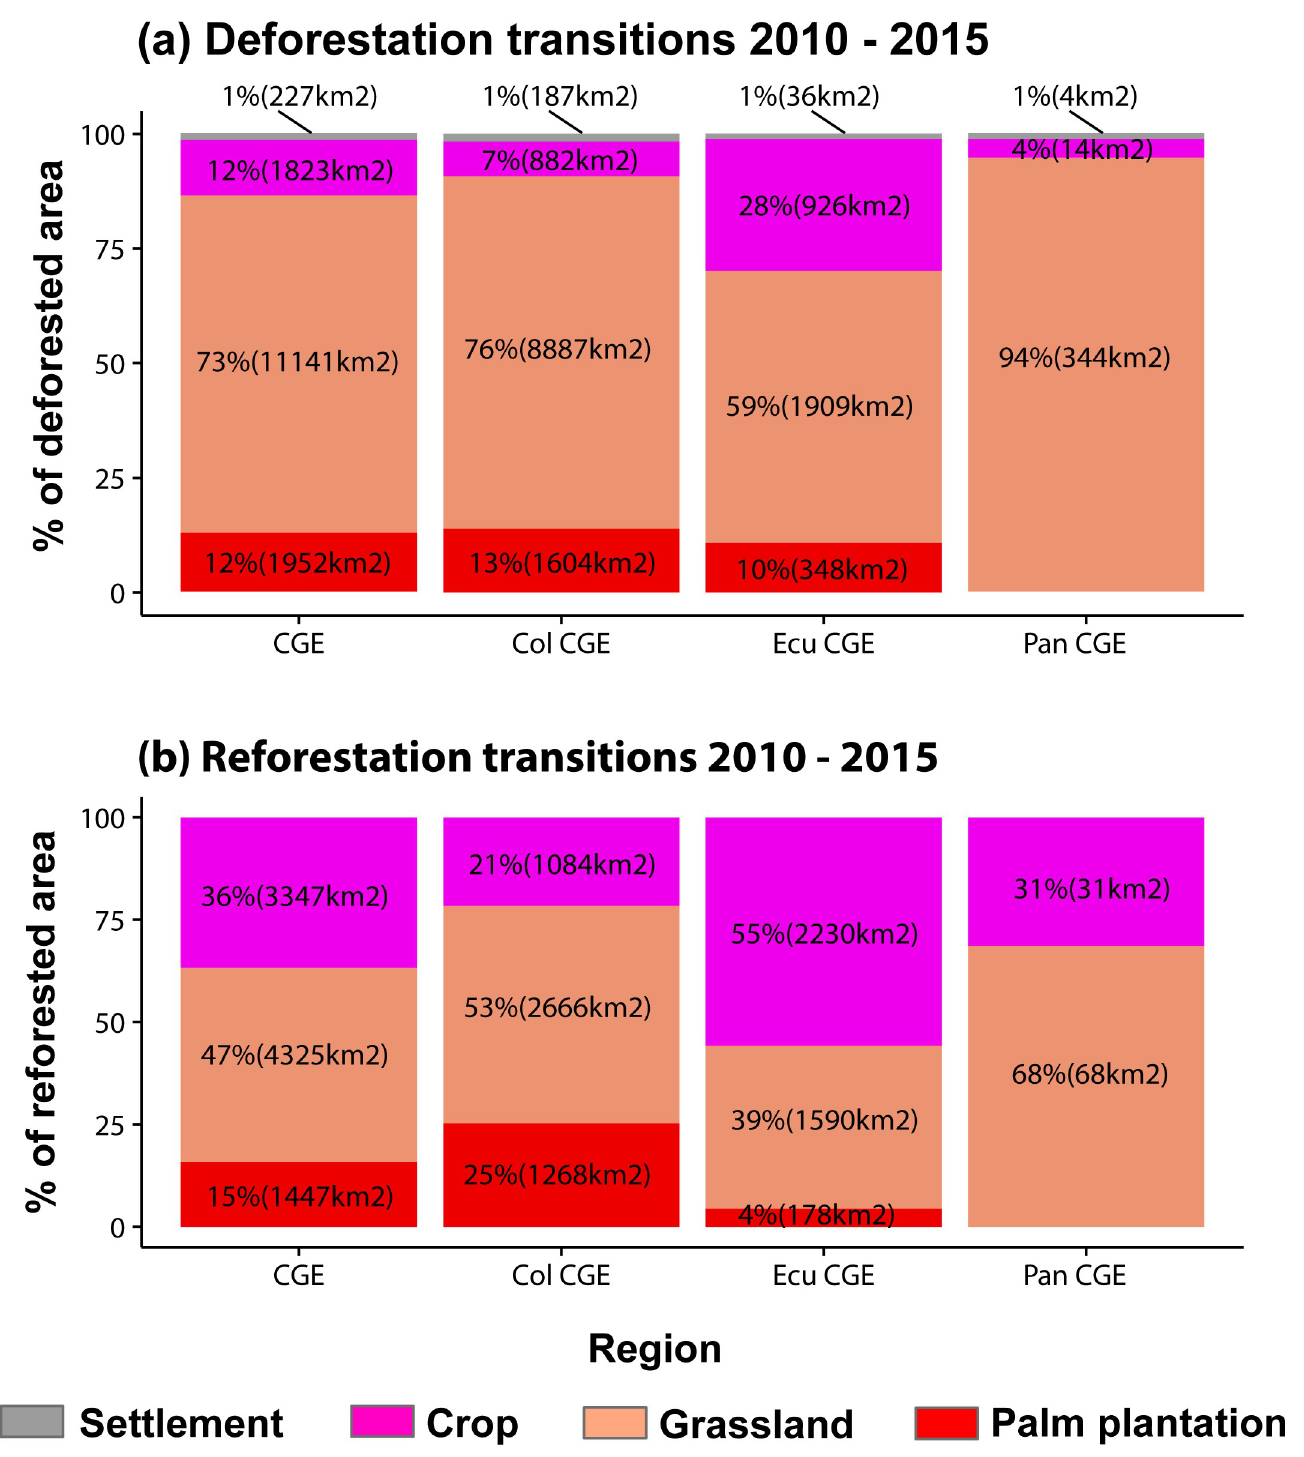
Fig 5. Quantification of deforestation (deforestation drivers) and reforestation transitions from 2010 to 2015. (a) Percentage of deforested area and net area deforested by every deforestation driver, and (b) percentage of reforested areas and net area reforested by every reforestation transition. The Choco´-Darien Global Ecoregion (CGE), Colombian CGE (Col CGE), Ecuadorian CGE (Ecu CGE), and Panamanian CGE (Pan CGE).